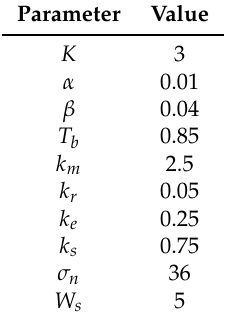
Table 6. Optimized parameter set on the video dynamic background